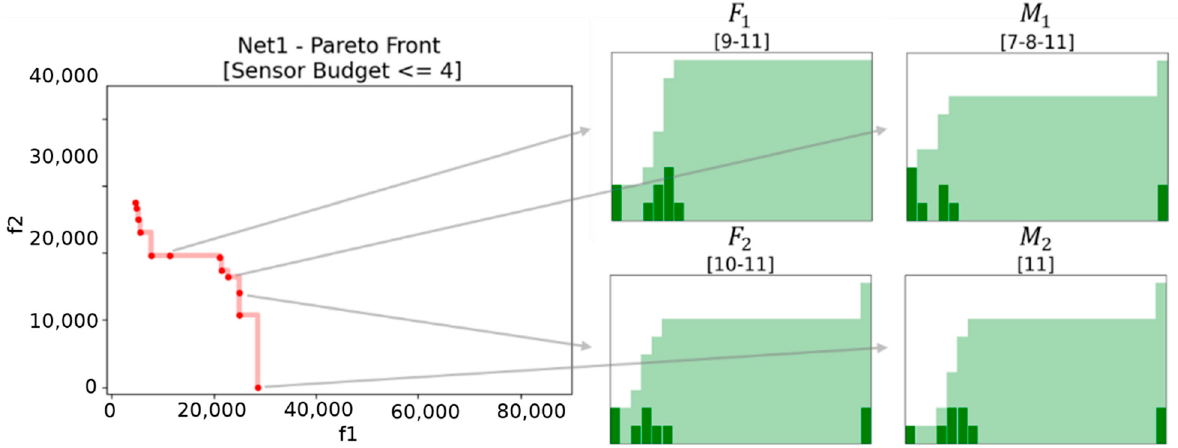
Figure 9. Two pairs of individuals are randomly sampled from the actual Pareto front. In this example, the pairs (𝐹 (cid:2869) , 𝑀 (cid:2869) ) = ([9,11],[7,8,11]) is choosen because 𝑊𝑆𝑇(cid:3435)𝐻 [(cid:2877),(cid:2869)(cid:2869)] , 𝐻 [(cid:2875),(cid:2876),(cid:2869)(cid:2869)] (cid:3439) = 18,800 (cid:3408) 𝑊𝑆𝑇(cid:3435)𝐻 [(cid:2869)(cid:2868),(cid:2869)(cid:2869)] , 𝐻 [(cid:2869)(cid:2869)] (cid:3439) = 4000 .